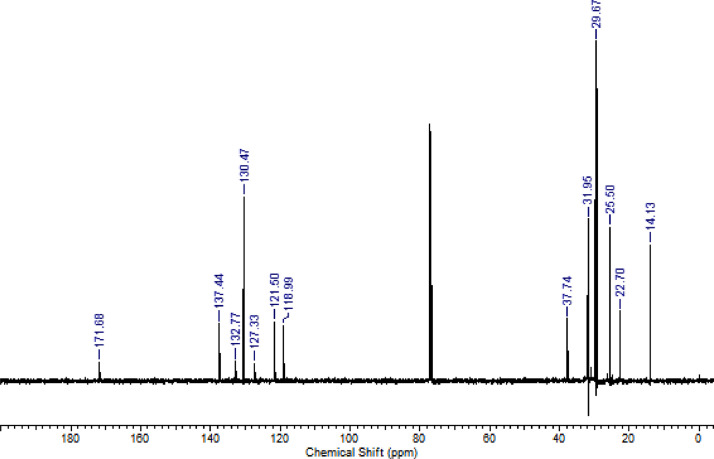
13C NMR (CDCl3, 100 MHz) spectrum of compound 11b.